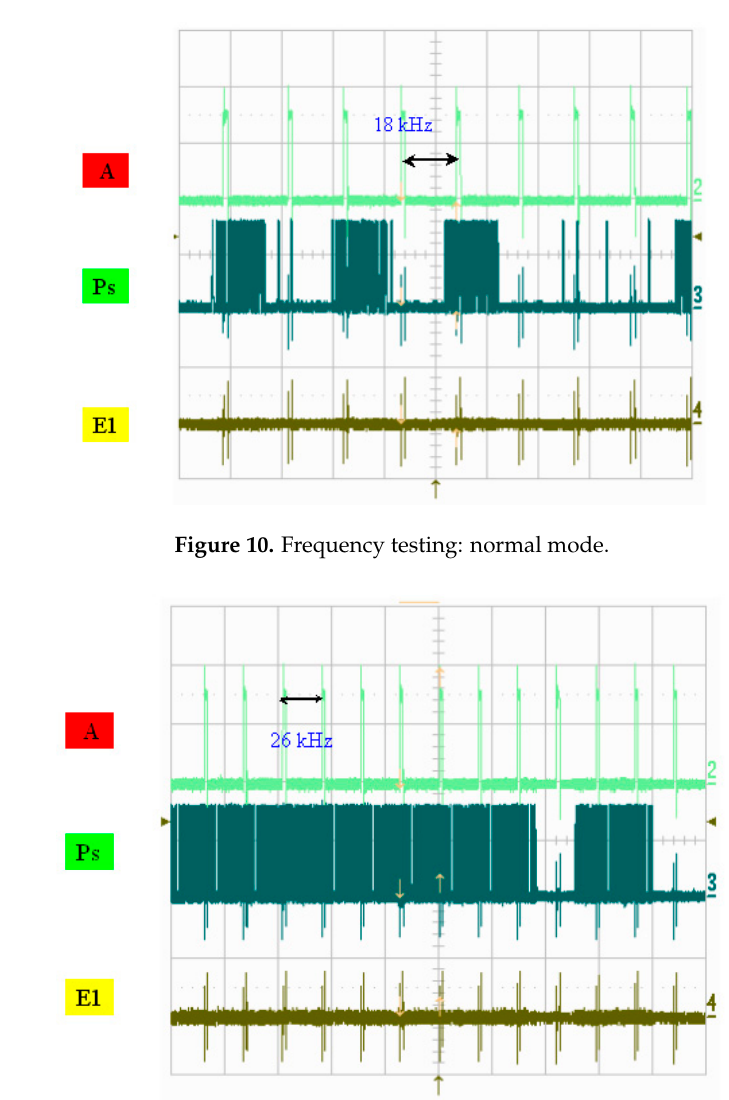
Figure 12. Frequency testing: best mode.